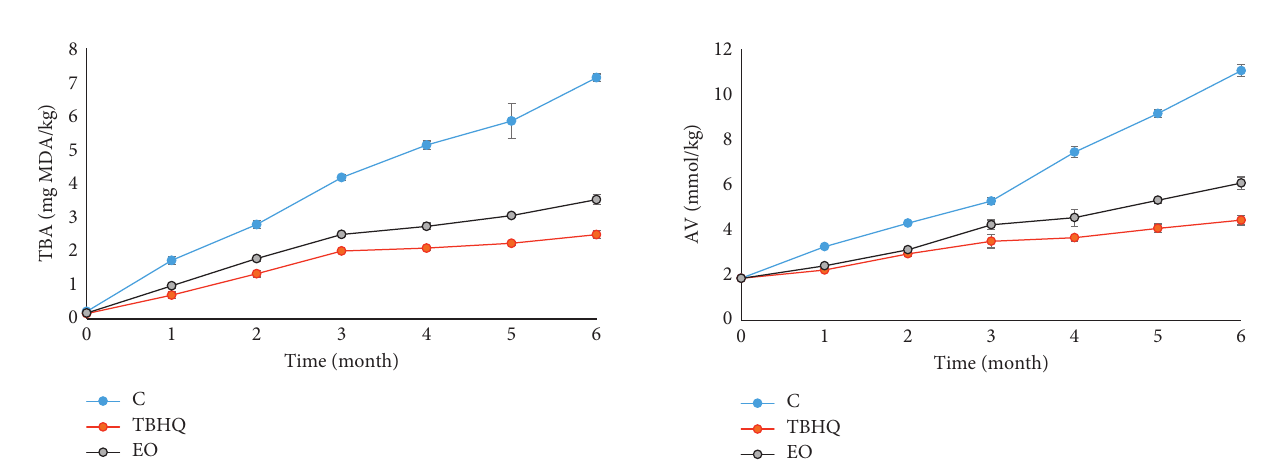
Figure 3: The anisidine index (mmol/kg) in different treatments of mayonnaise during 6 months. EO: sample containing Z. multiflora essential oil; TBHQ: sample containing synthetic antioxidant TBHQ; C: control sample